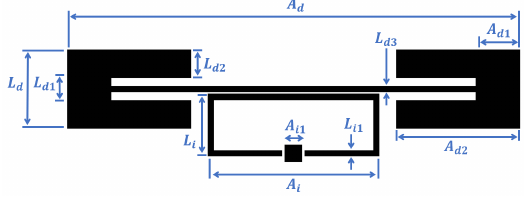
Figure 23. Layout of the implemented antenna. Table 8. Parameters of the dipole antenna.